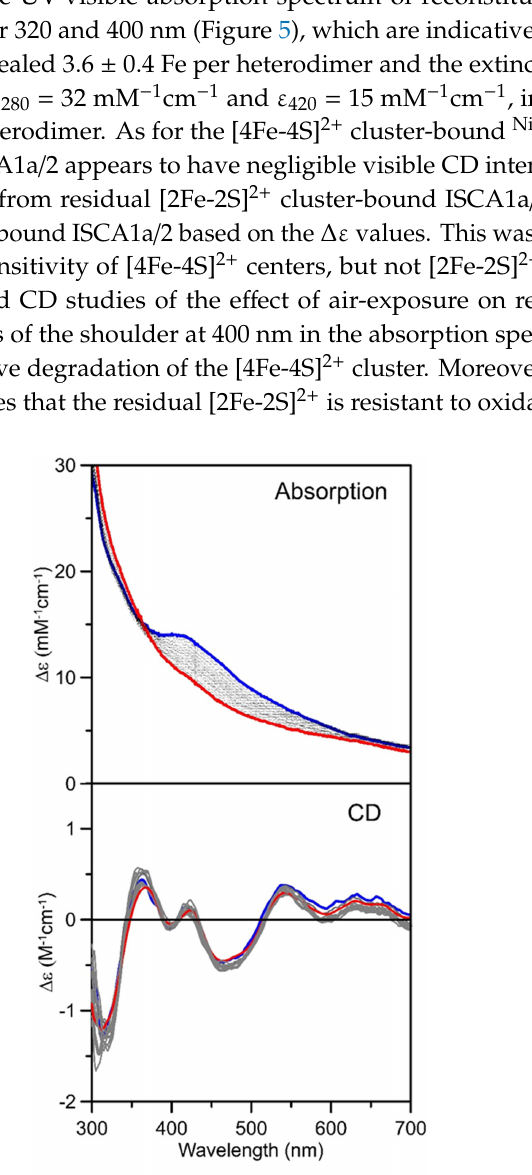
Figure 7. Oxygen degrades [4Fe-4S] 2+ clusters, but not [2Fe-2S] 2+ clusters, in reconstituted At ISCA1a/2. Anaerobically-reconstituted [4Fe-4S] 2+ cluster-bound (thick blue lines) was monitored in 1 cm cuvettes by UV-visible absorption and CD for 180 min after exposure to air (thin gray lines). The final spectra recorded after 200 min is shown as thick red lines. The CD spectra only monitor oxygen-induced changes in the minority (20%) [2Fe-2S] 2+ cluster-bound form of ISCA1a/2, since the majority (80%) [4Fe-4S] 2+ cluster-bound form does not exhibit a significant CD spectrum. All ε and Δε values are based on ISCA1a/2 heterodimer concentration.